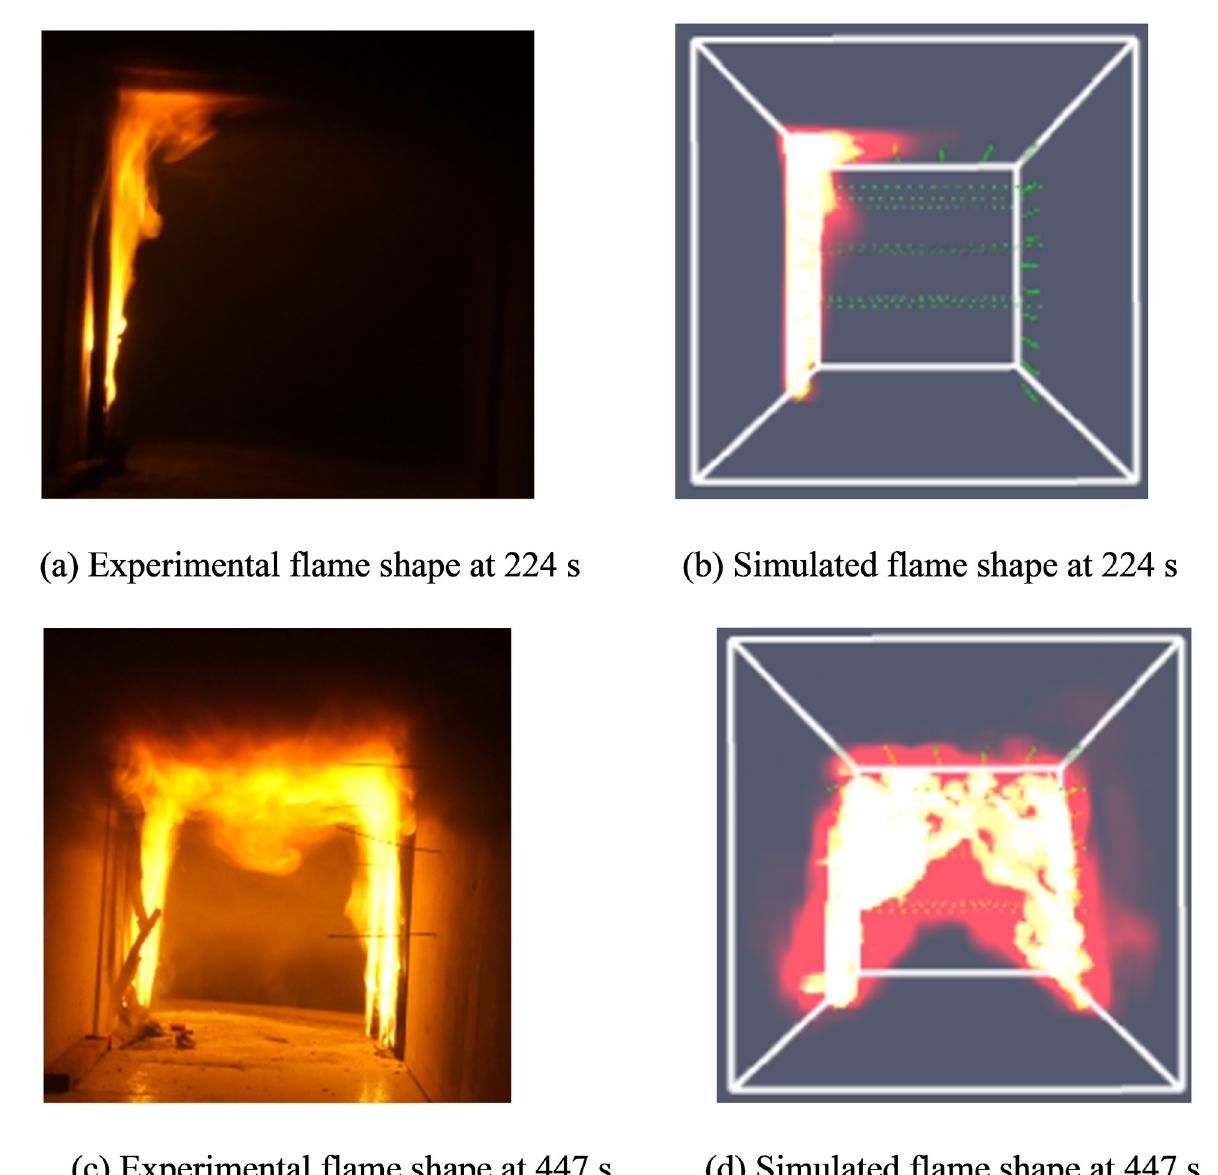
Fig 10. Comparison of the flame shape cross-section between experiments and fire